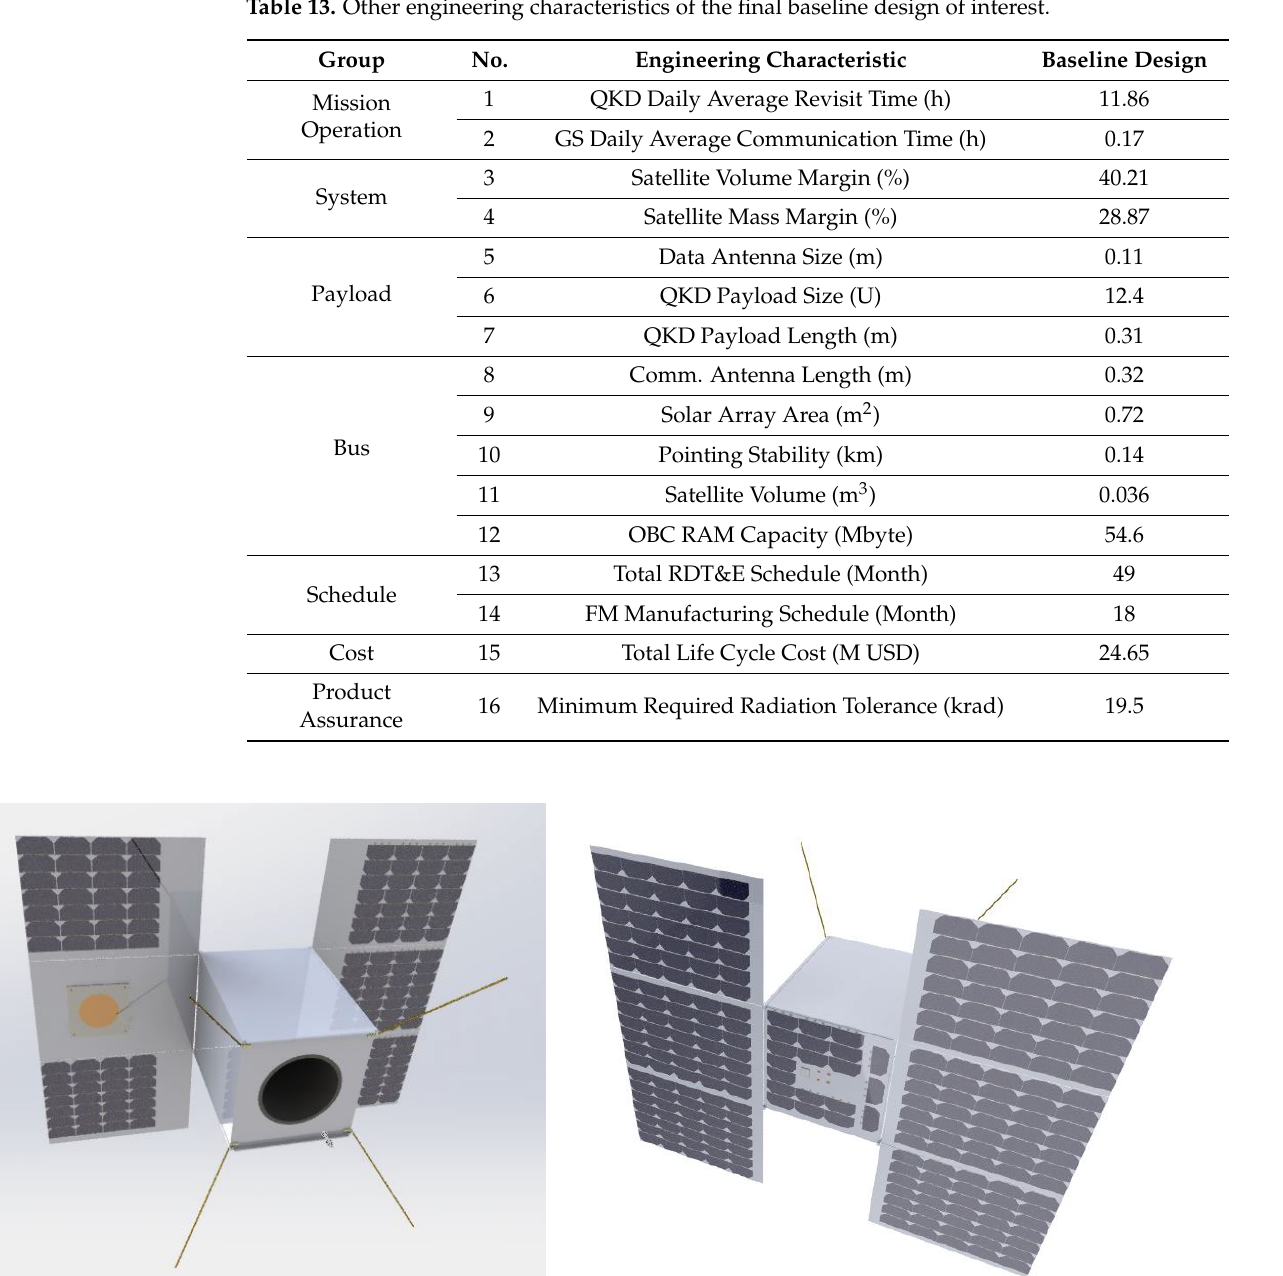
Table 13. Other engineering characteristics of the final baseline design of interest.